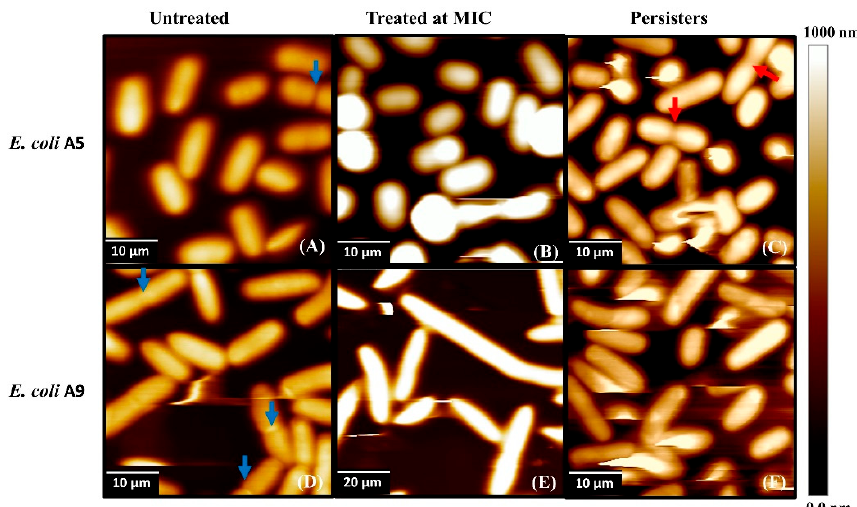
Figure 2. Representative AFM height images showing morphological differences among: ( A, D ) natural MDR cells of Strains A5 and A9, respectively; ( B, E ) cells treated with ampicillin at various MICs for Strains A5 and A9, respectively; and ( C, F ) persister cells of Strains A5 and A9, respectively. Red arrowheads indicate dividing cells in the persister cells’ subpopulations (image C ), blue arrowheads depict dividing cells in the absence of ampicillin (images A and D ), and green arrowheads show elongated cells after exposure to MIC (image E ).